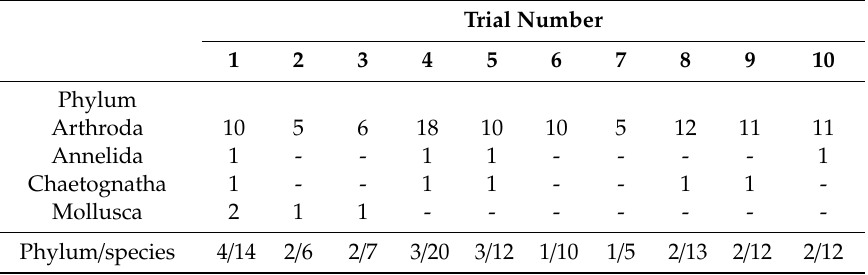
Table 7. Number of phylum and species of ≥ 50 sized organisms in shipboard